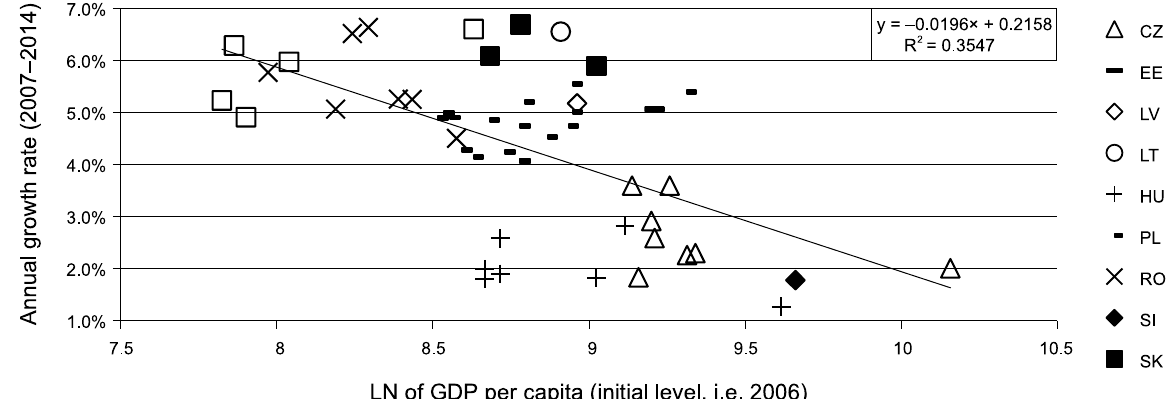
Fig. 4. Beta-convergence of CEE regions (2007–2014).